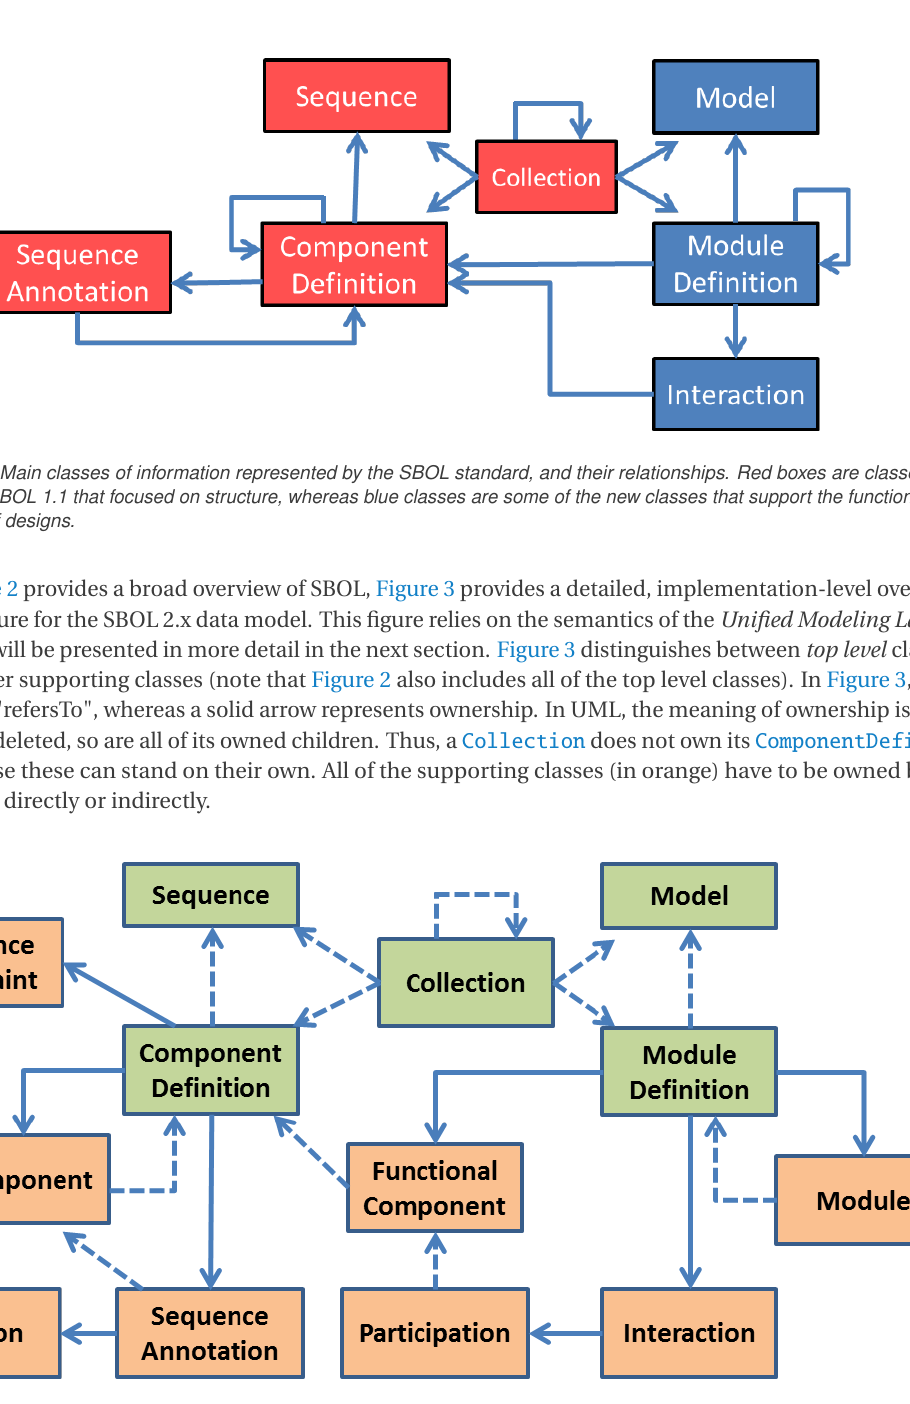
Figure 3: Main classes of information represented by the SBOL 2.x standard, and their relationships. Green boxes are “top level” classes, while the other classes are in support of these classes. Solid arrows indicates ownership, whereas a dashed arrow indicates that one class refers to an object of another